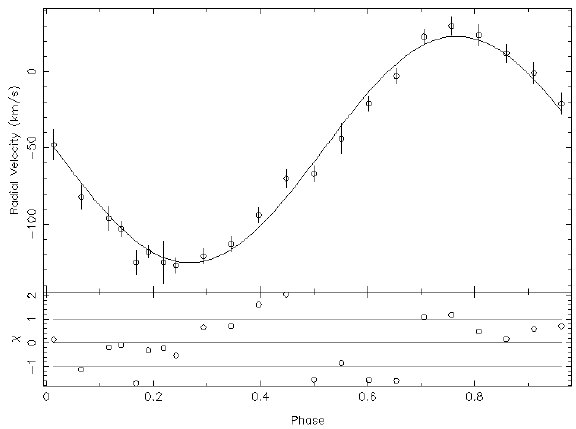
Figure 2. Phased and fitted RV curve of PTF1 J0113 using the Keck ESI spectra. In the bottom panel the residuals are